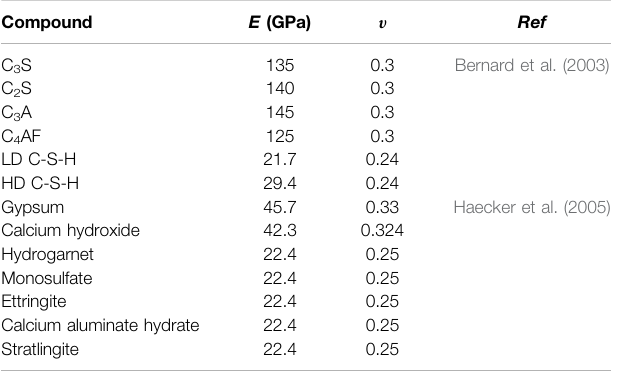
FIGURE 4 | Comparison of results obtained in our model, the simulation results of Zhao et al. (2013), and experimental results of Boumiz et al. (1996) for different w/c